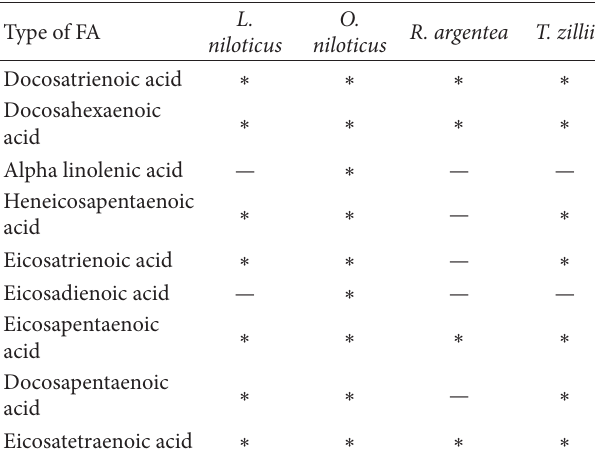
Figure 3: The EPA levels in R. argentea , O. niloticus , T. zillii , and L. niloticus